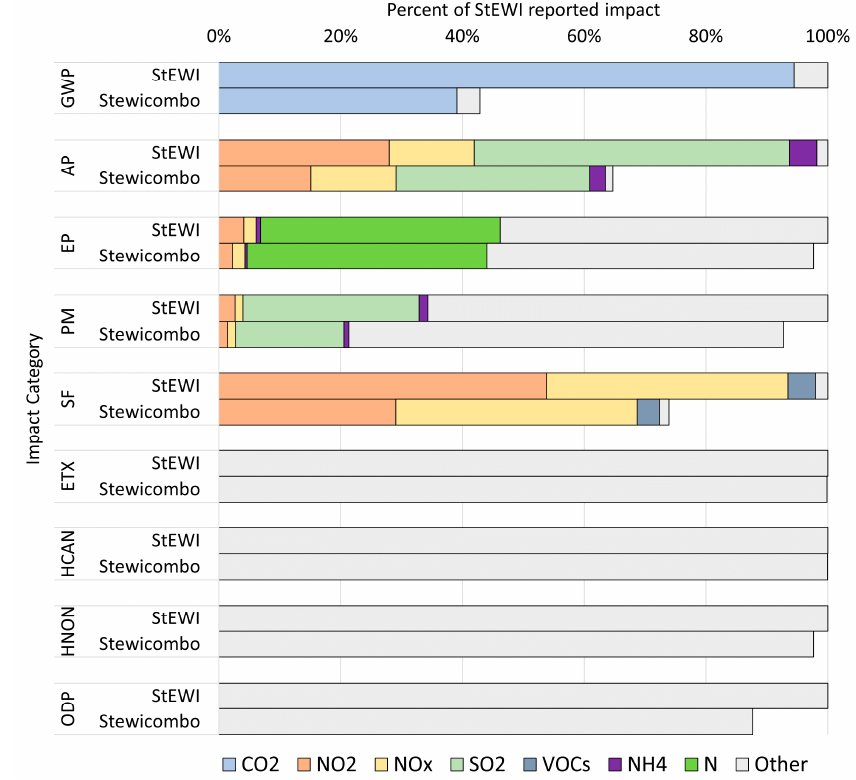
Figure 5. National contribution of Life Cycle Impacts by Flow in 2018. GWP, global warming potential; AP, acidification potential; EP, eutrophication potential; PM, particulate matter formation; SF, smog formation; ETX, ecotoxicity; HCAN, human-health cancer; HNON, human-health noncancer; ODP, ozone depletion potential.